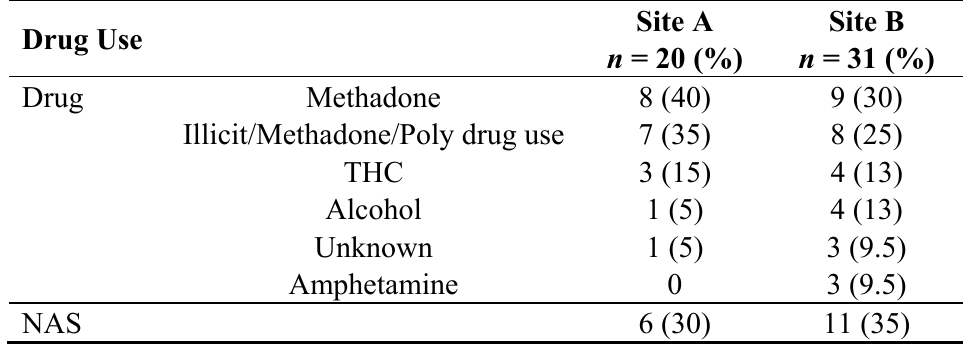
Table 1. Drug use identified at Site A and B.